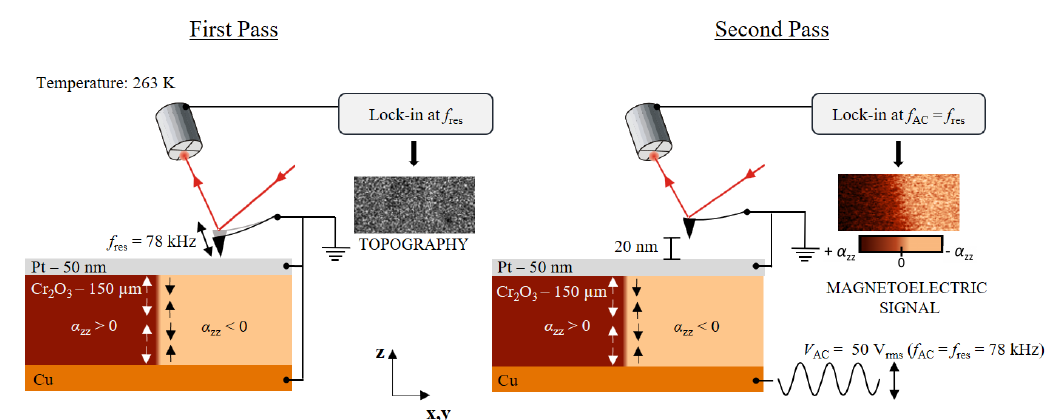
Figure 1. The principle of MeFM. In the first pass, the topography is detected in tapping mode with the tip oscillating at its resonance frequency ( f res ). To avoid electrostatic contributions, the whole system is grounded. In the second pass, the tip is lifted to a height of about 20 nm, and the mechanically driven oscillation is stopped. Instead, an AC voltage is applied to the back electrode. The applied voltage induces an oscillating magnetic field via the LME. Opposite 180 ◦ domain states exhibit a relative phase difference in the magnetoelectric signal of 180 ◦ . This phase shift is detected by a lock-in amplifier and transferred into a contrast between different antiferromagnetic domains in the second